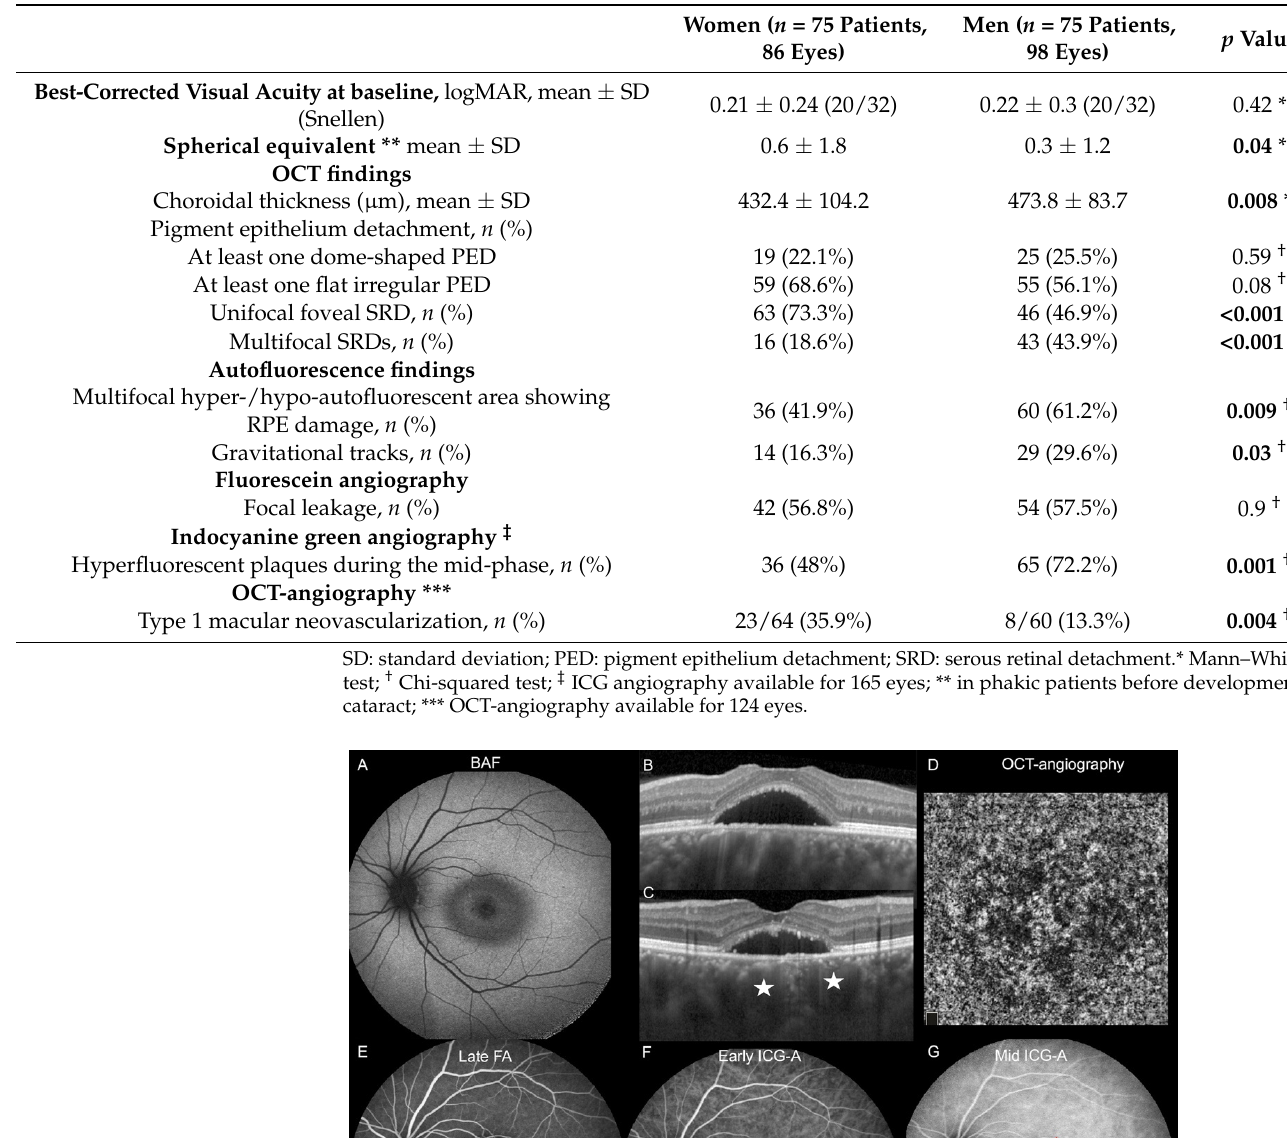
Table 2. Comparison of the clinical characteristics and multimodal imaging findings of patients with central serous chorioretinopathy, according to gender.